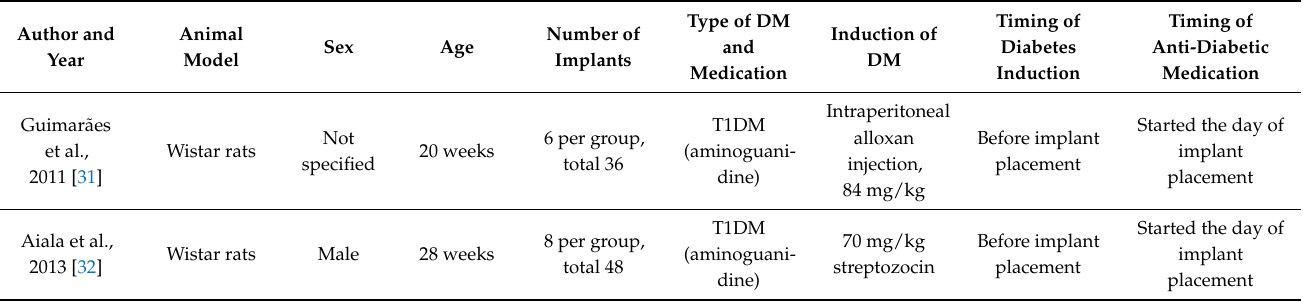
Table 2. Animal species/strain, demographics (age, sex), number of implants, timing and mode of induction, timing of anti-diabetic